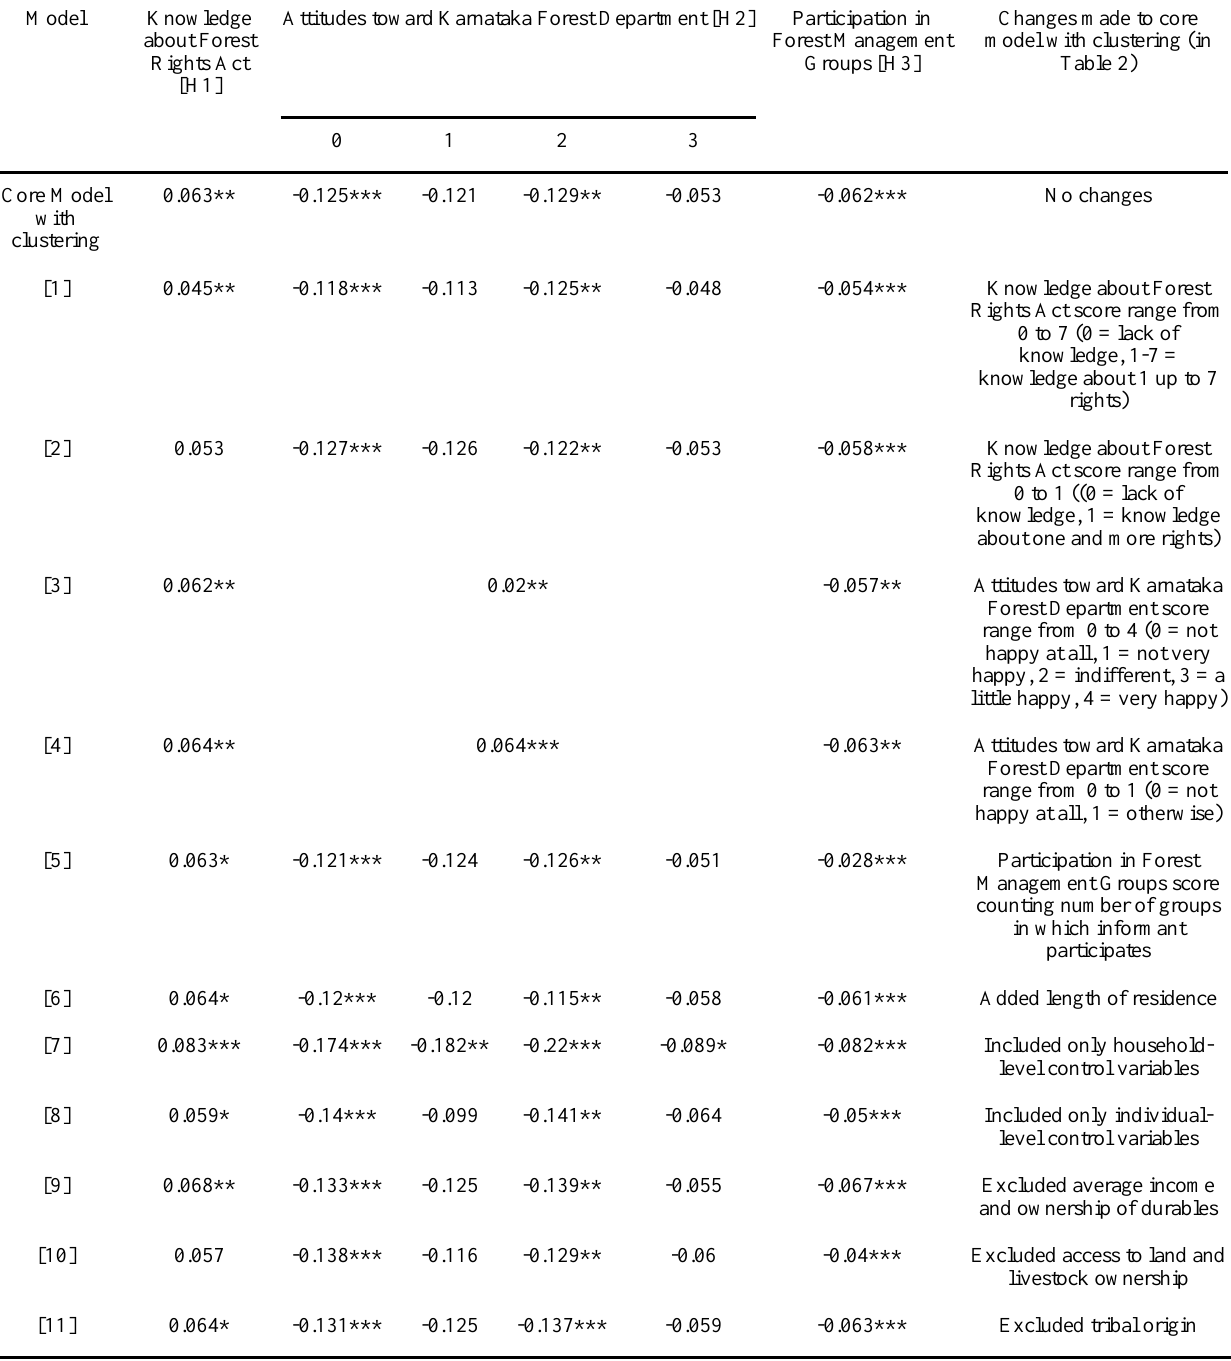
Table 3. Robustness test: regressions of attitudes toward reserved forest (dependent variable) against attitudes toward Karnataka Forest Department, knowledge about Forest Rights Act, and participation in forest management groups (N = 247) with clustering by land tenure and management regimes. Asterisks denote level of significance * at 10%; ** at 5%; *** at